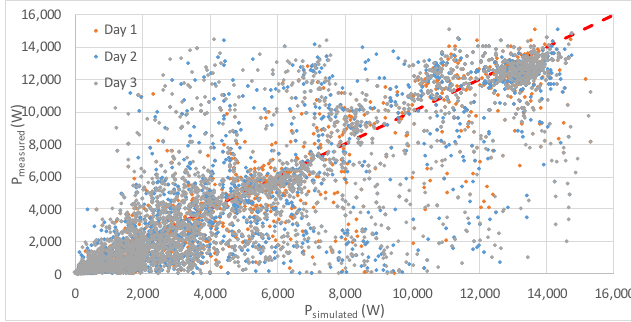
Figure 9. Simulation of PV system power output for three consecutive days (red line is to guide your eyes). Table 5. Simulation errors for three consecutive days.